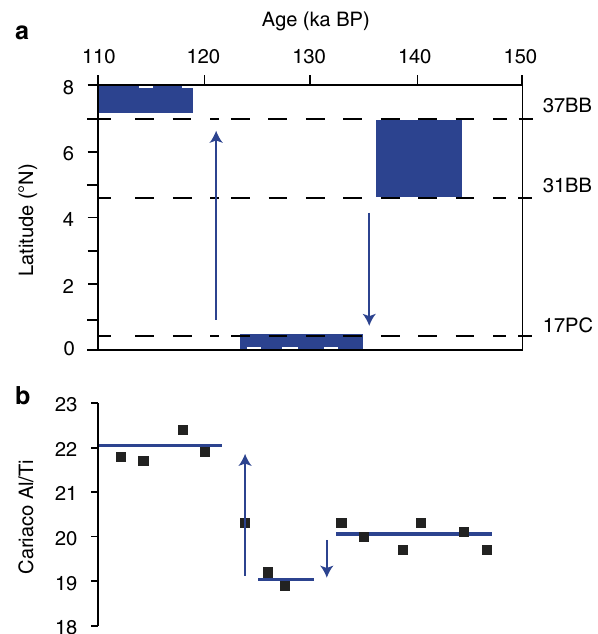
Figure 3 | Termination II ITCZ shifts. Blue boxes indicate range of possible latitudes of the mean ITCZ position, black dashed lines denote core latitudes ( a ). Cariaco Basin Al/Ti record (black squares) 28 with blue bars indicating estimates of the relative ITCZ position through time ( b